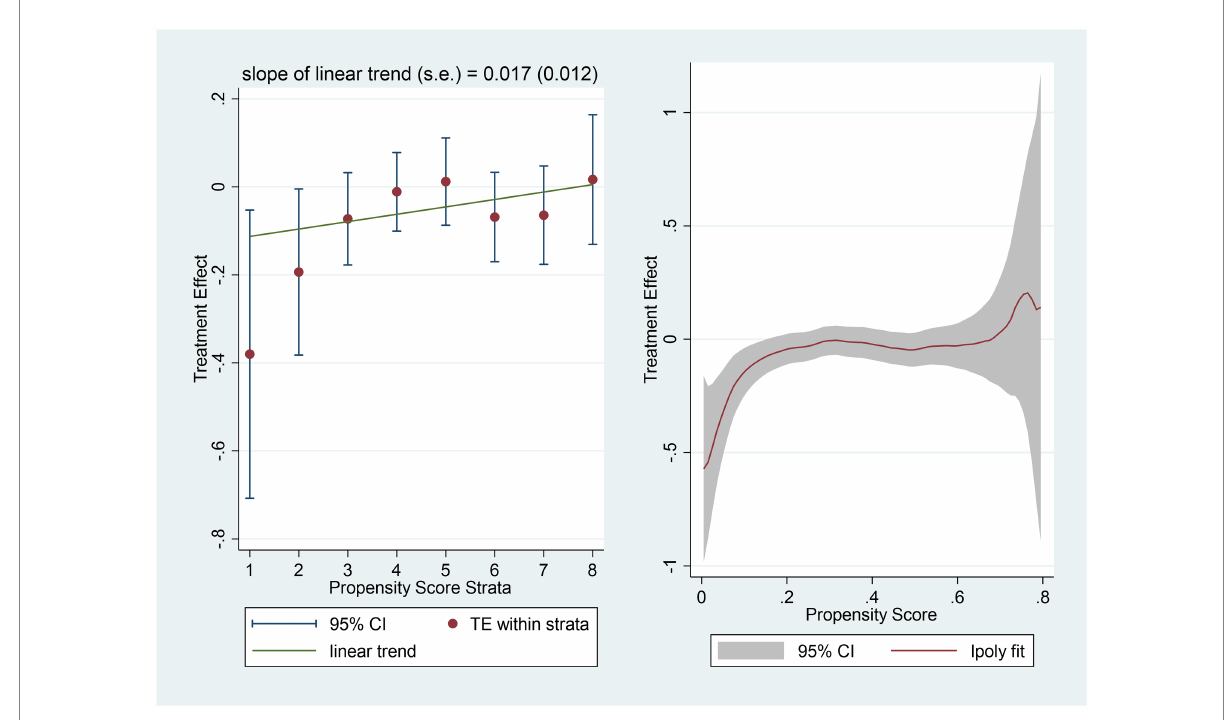
FIGURE 1 Heterogeneous treatment effects of Individual social capital and overall satisfaction with medcial services